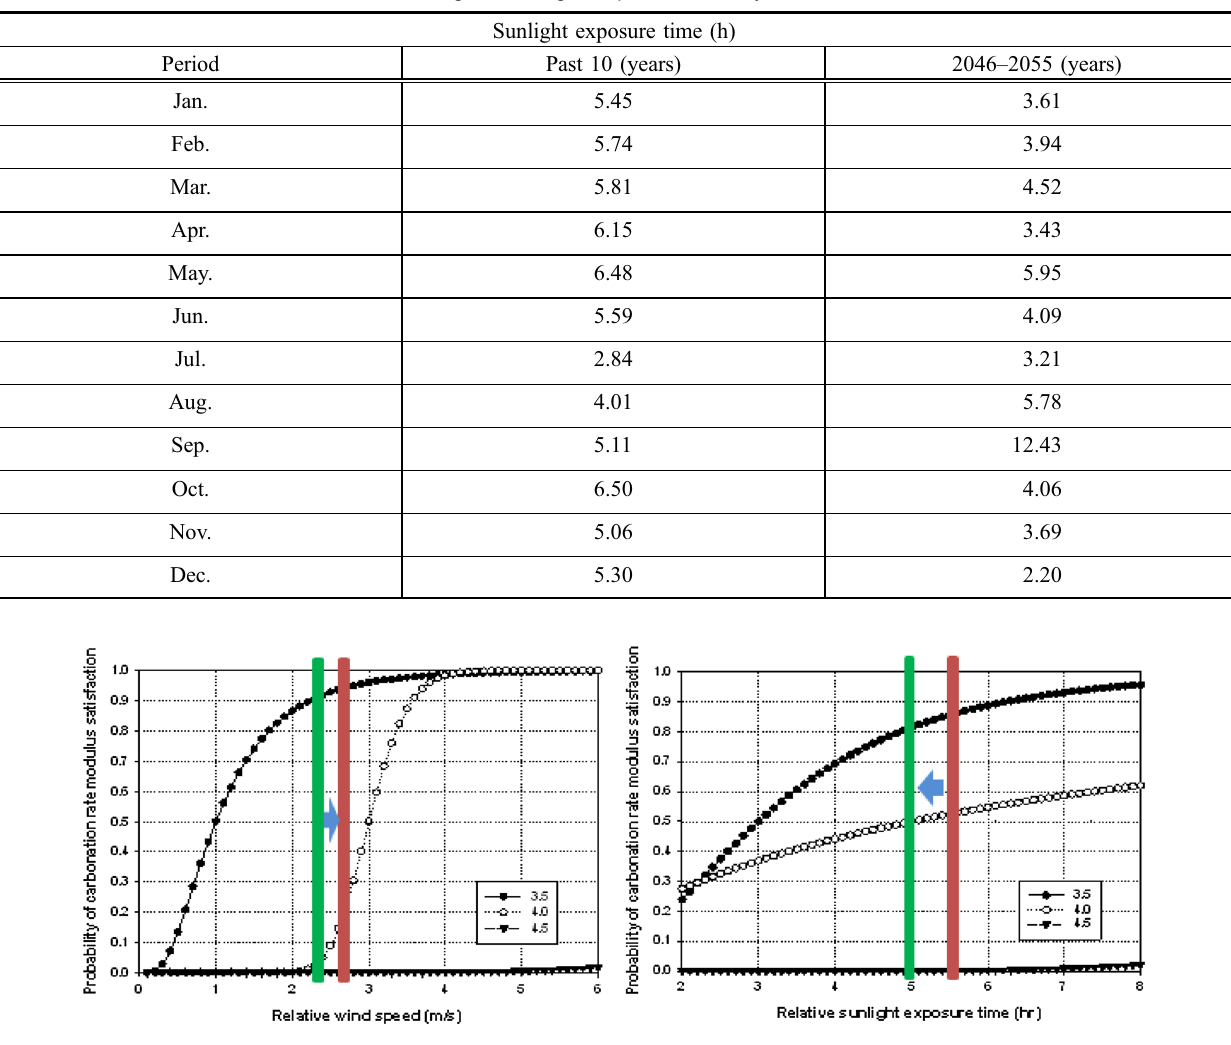
Fig. 13 Application of RCP for climate change scenarios on carbonation speed